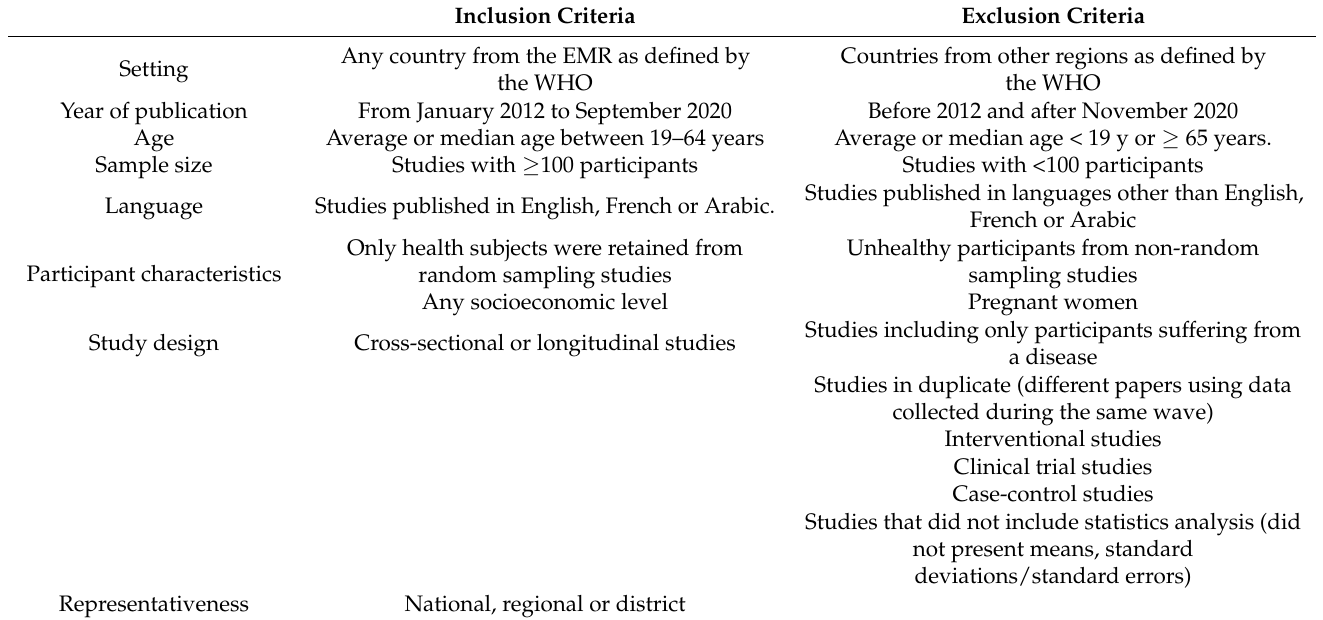
Table 1. Inclusion and exclusion criteria for the selection of